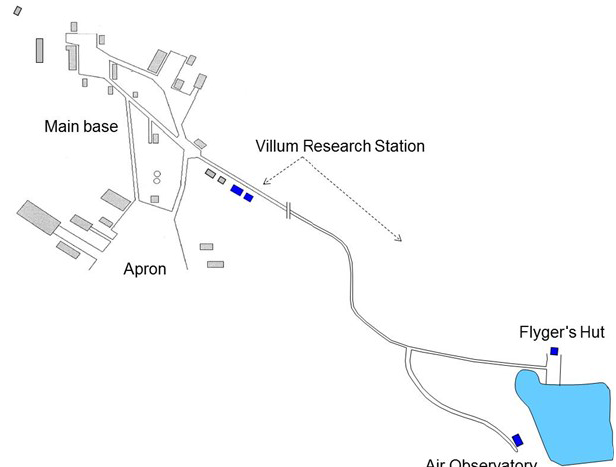
Figure 2. Map of Villum Research Station with its buildings (blue) relative to the Station Nord military outpost. Flyger’s hut and the Air Observatory are located about 2km outside main base of Station Nord. Until 2014, all measurements were performed at Flyger’s hut; thereafter, they were moved to the Air